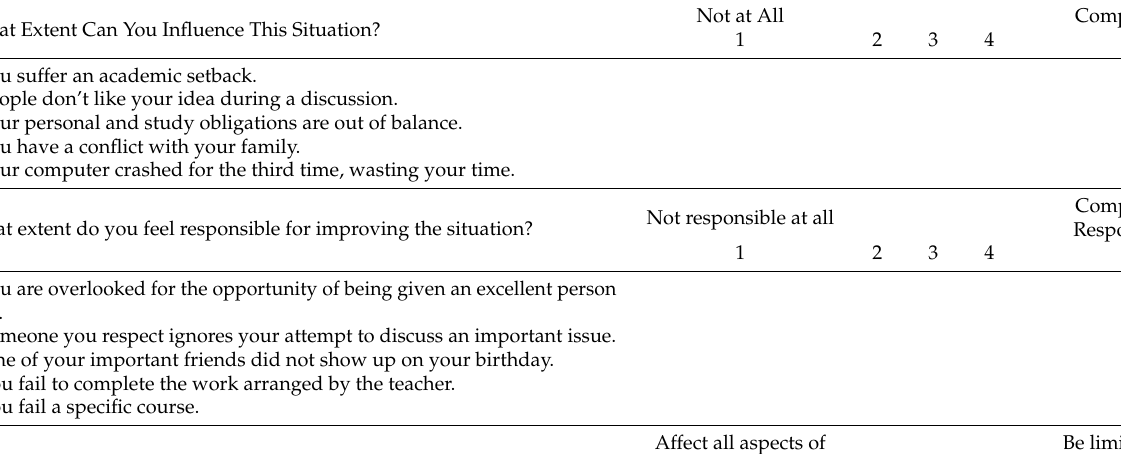
Table A1. The Adversity Response Profile for Chinese University Students